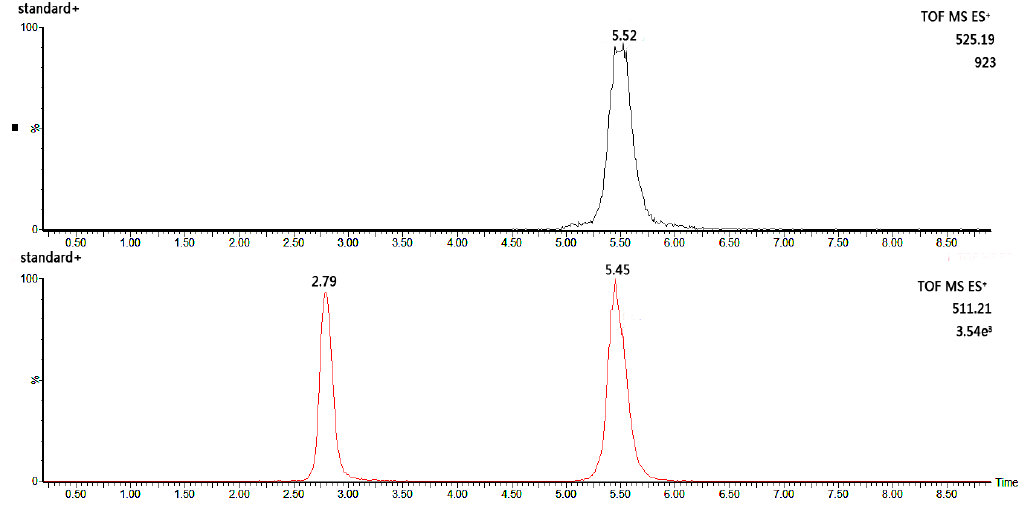
Figure 2. The extracted ion chromatograms of glucuronic acid and glucose.